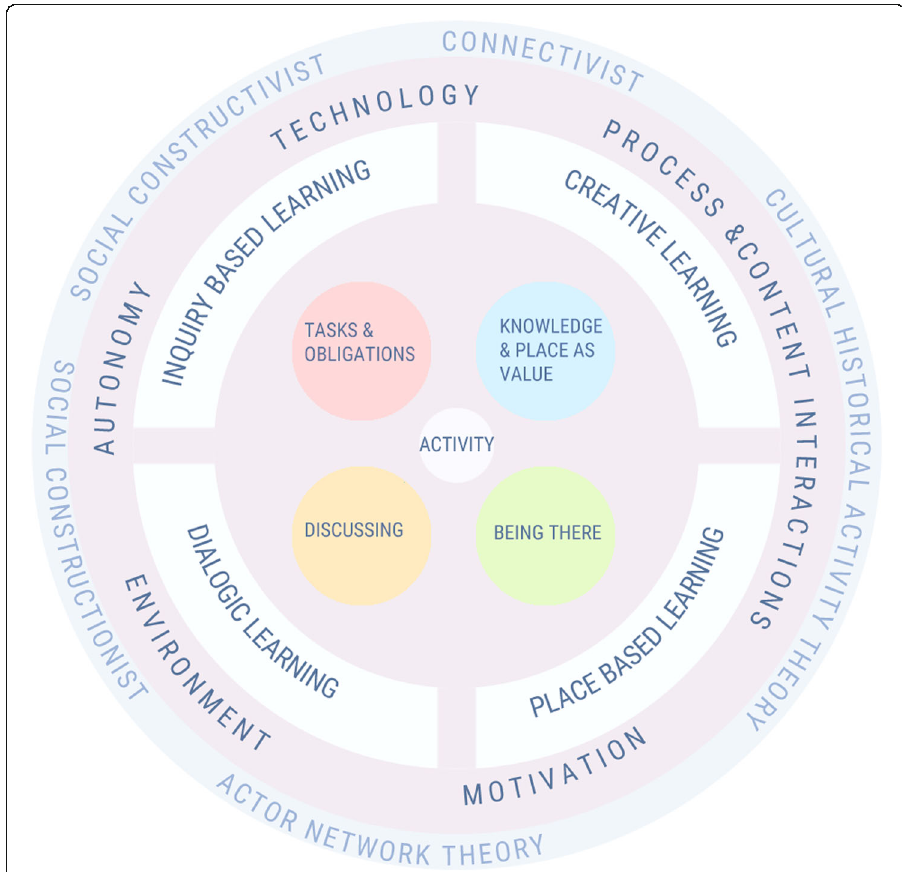
Fig. 1 Visualisation of the Pedagogy of Experience Complexity for Smart Learning (PECSL)